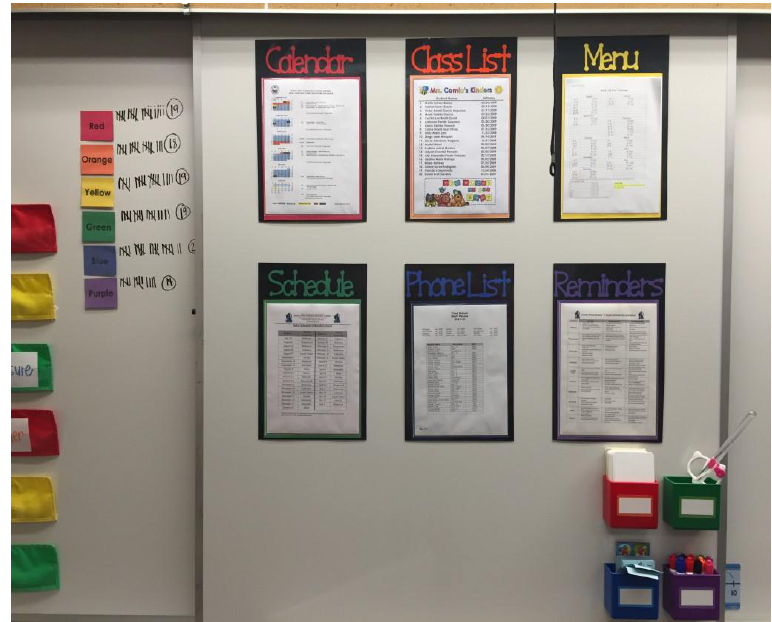
Figure 4. Standardize the Classroom